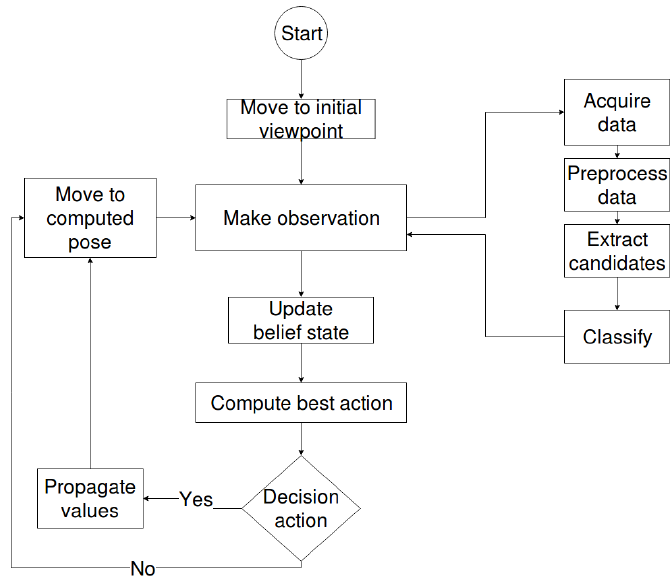
Figure 5. The workflow of the